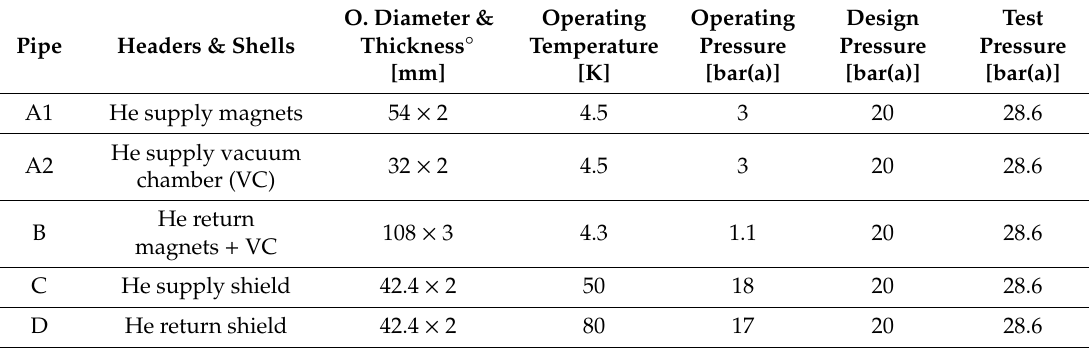
Figure 4. General cross-sectional layout of the SIS100 bypass line: without supports ( left ); with supports ( right ). A1, A2, B, C, D—helium process pipes, BB—superconducting busbars. Table 1. The specification of the design and operating parameters of the process pipes.